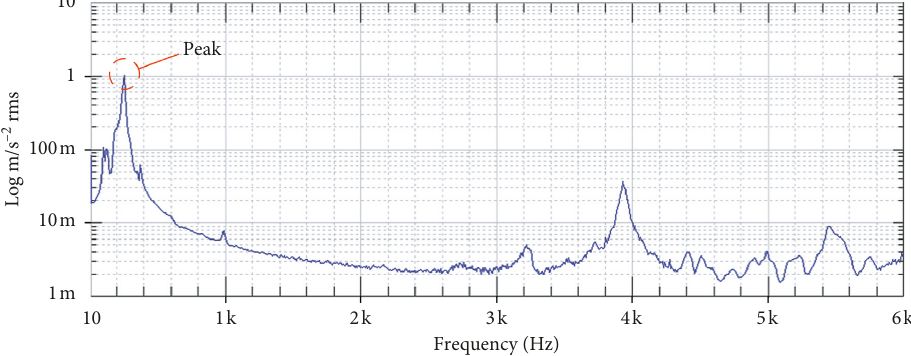
Figure 6: Frequency response function (FRF) curve of the boring bar.